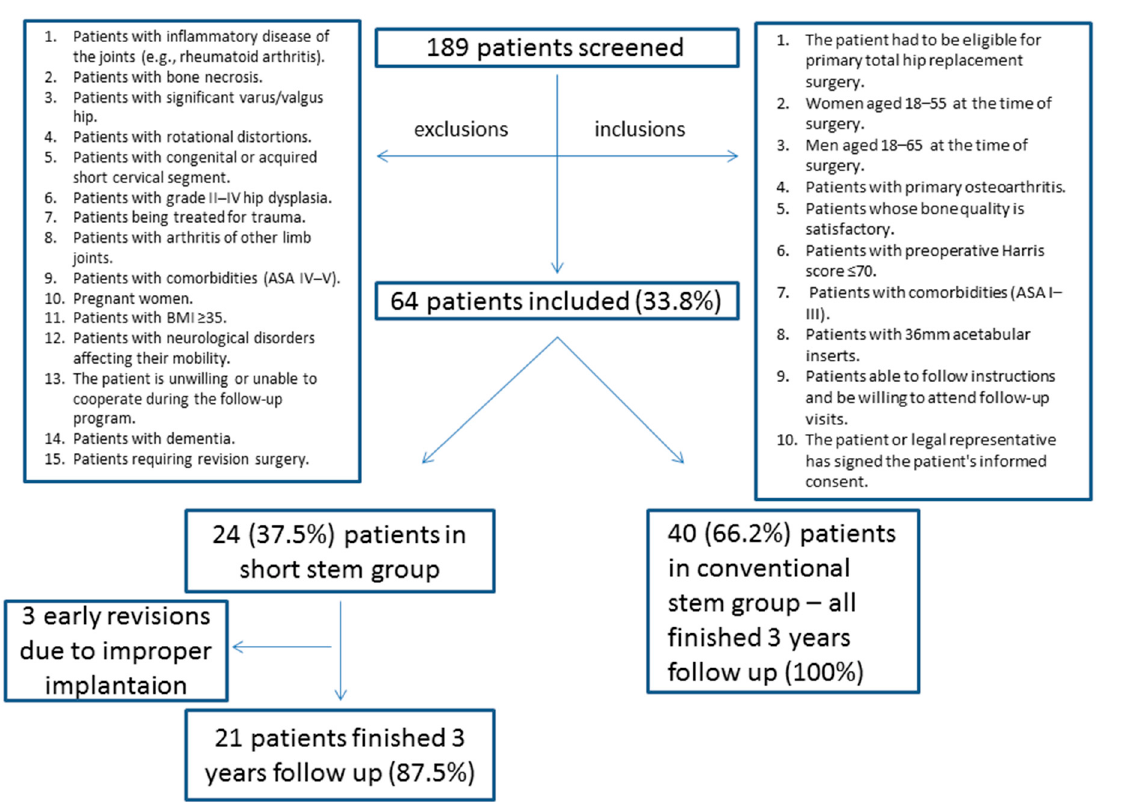
Figure 1. STROBE diagram detailing the inclusion and exclusion